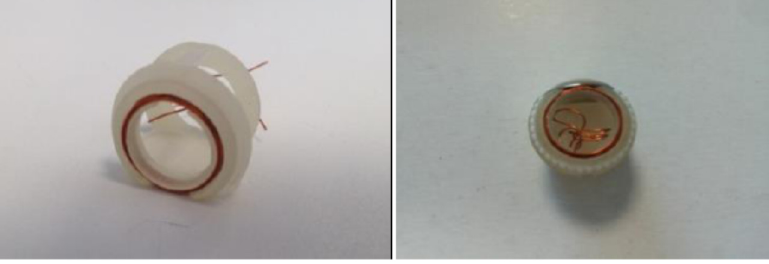
Figure 9. Manufactured receiver coil integration within the